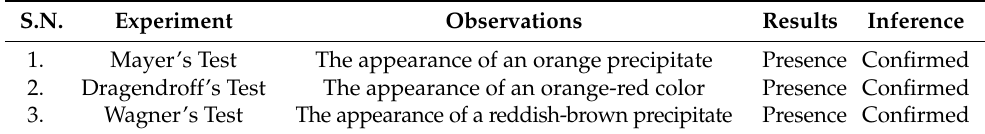
Table 2. Chemical tests of the Acacia catechu alkaloids.